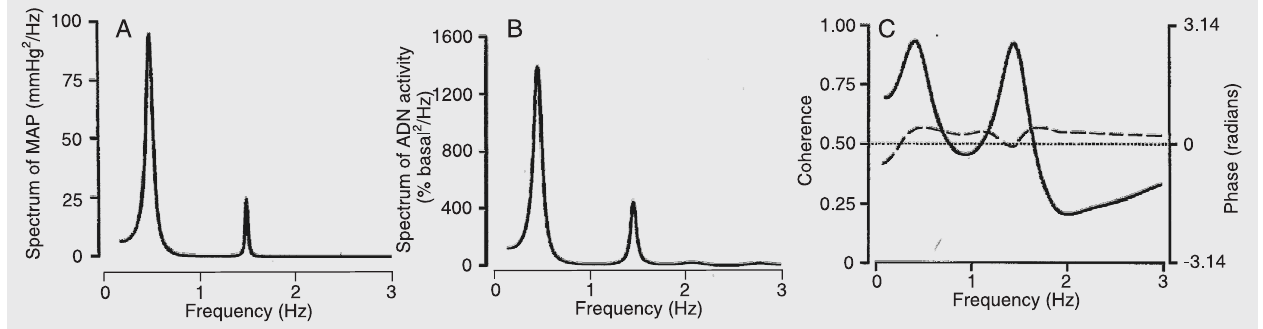
Figure 3. Time series of representative spectra collected from a representative rat during basal recording of mean arterial pressure (MAP, A), integrated aortic depressor nerve activity (ADN, B), coherence (at 0.3 and 1.3 Hz) and phase between the two spectra